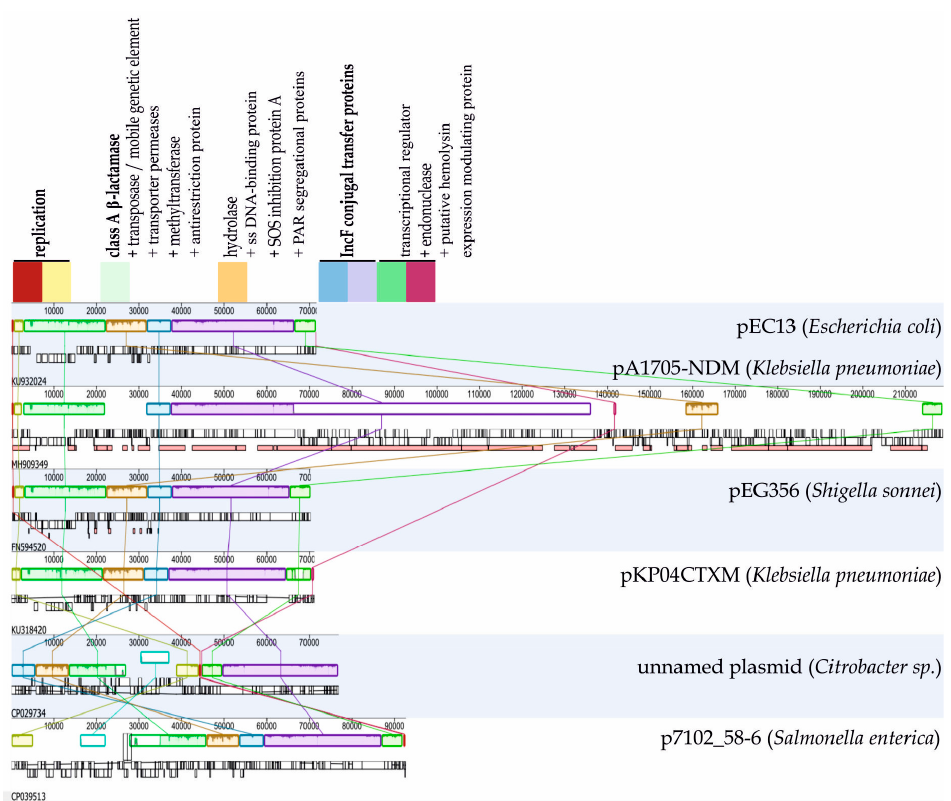
Figure 2. Comparison of pEC13 to related plasmids in other Enterobacteriaceae. The genetic regions are color-coded according to their predicted function (the exact gene contents within the regions vary between plasmids). Plasmids with relatively similar genetic contents and synteny to pEC13 are present in various bacterial species, hence the interspecific evolutionary rescue via horizontal gene transfer.